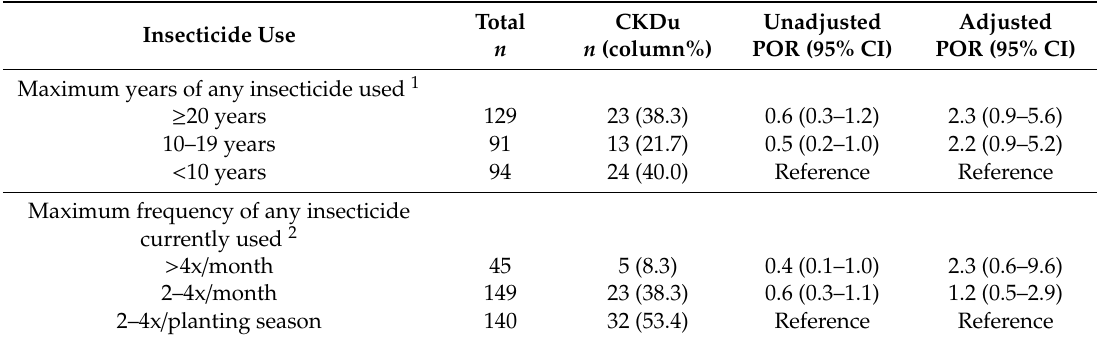
Table 6. Unadjusted and adjusted odds of CKDu according to insecticide use among male farmers in study location in West